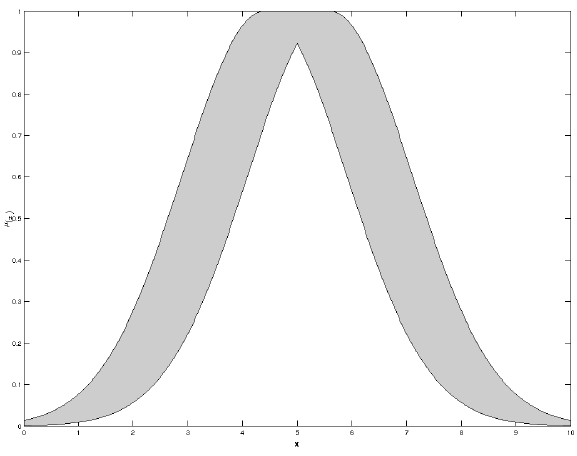
Figure 3. Support of the primary membership function of the used GT2 FS.